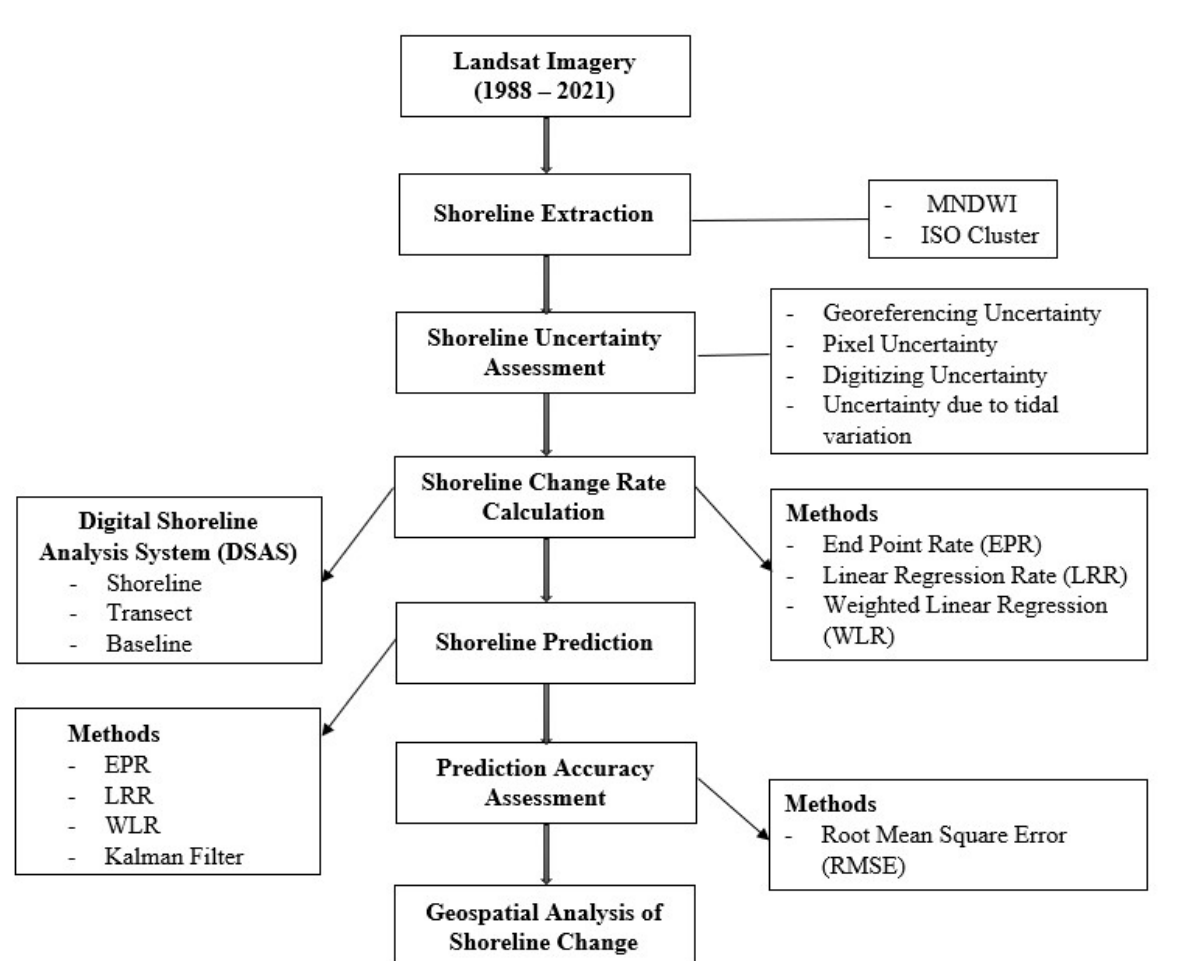
Figure 2. Flowchart of the methodology followed to conduct this study.